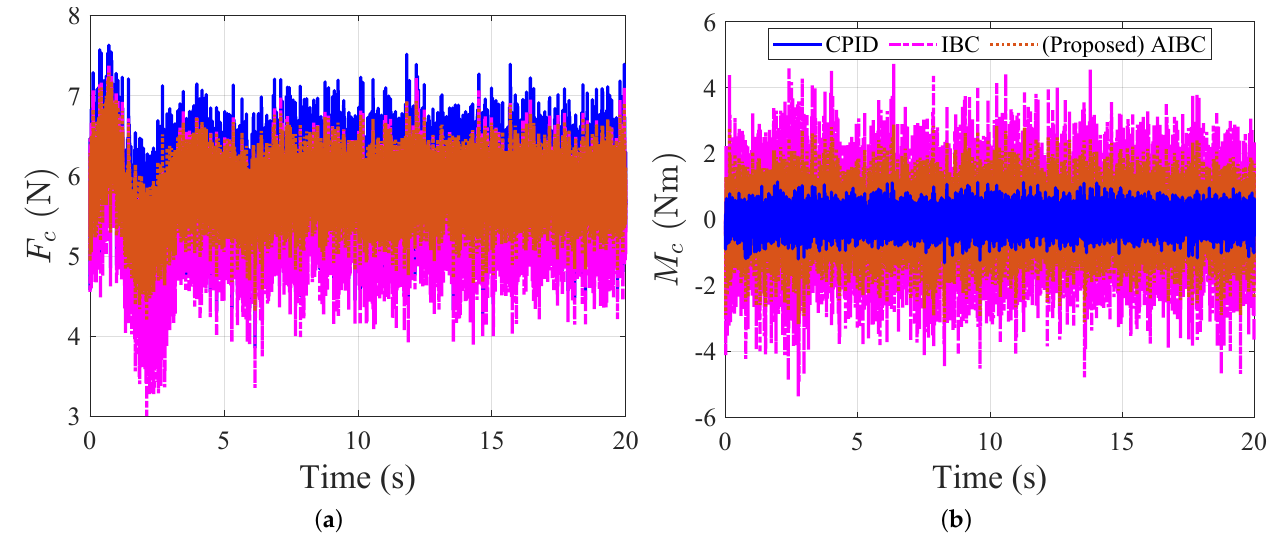
Figure 10. Comparison of computed control force and torque for different approaches. ( a ) com- puted control force; ( b ) computed control torque.